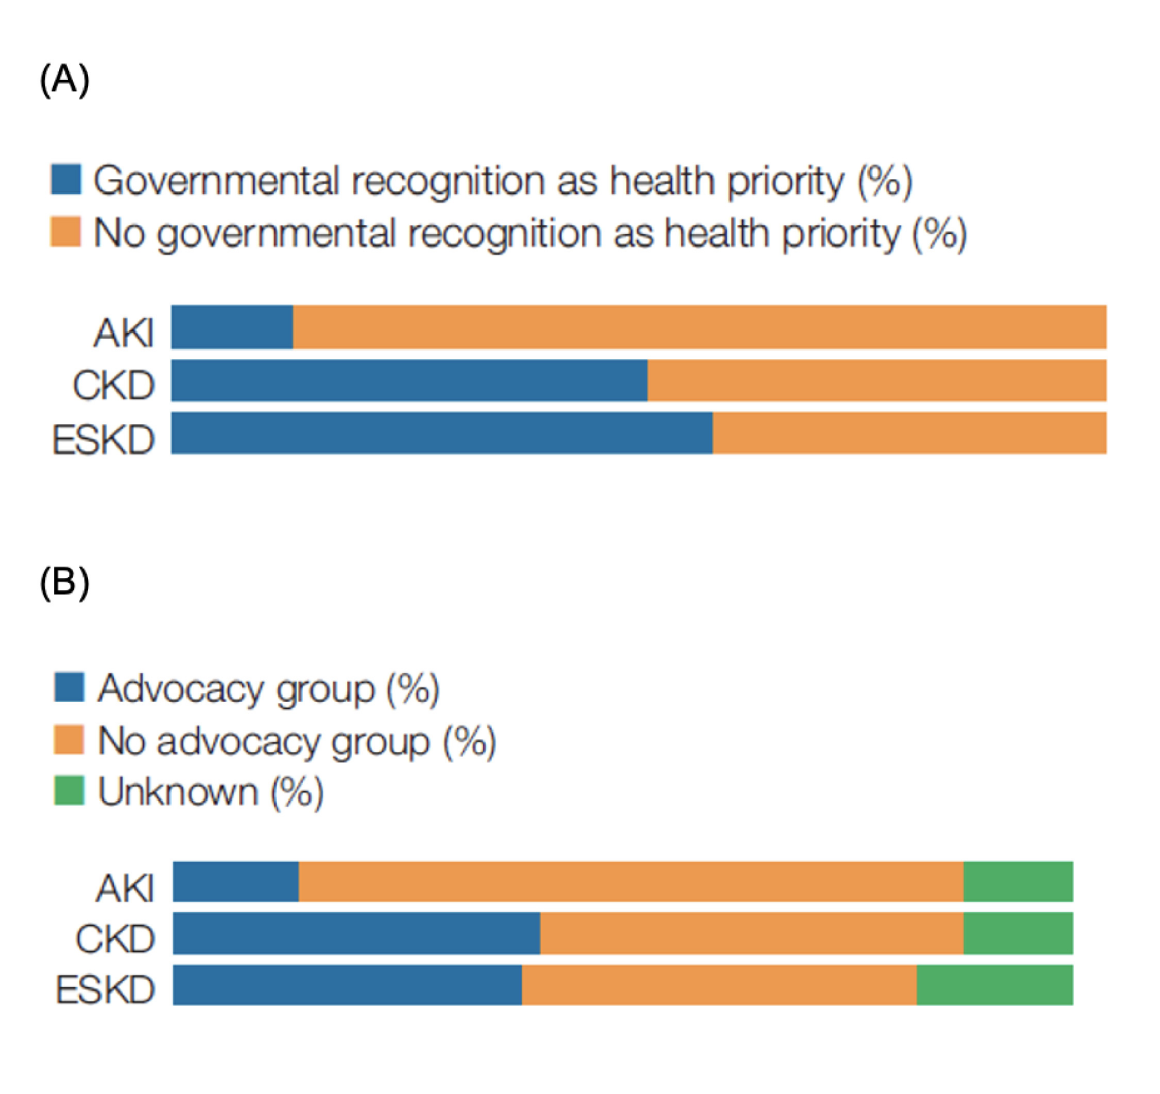
Fig 2. Government recognition as a priority (A) and availability of an advocacy group (B) for AKI, CKD, and kidney failure treatment and